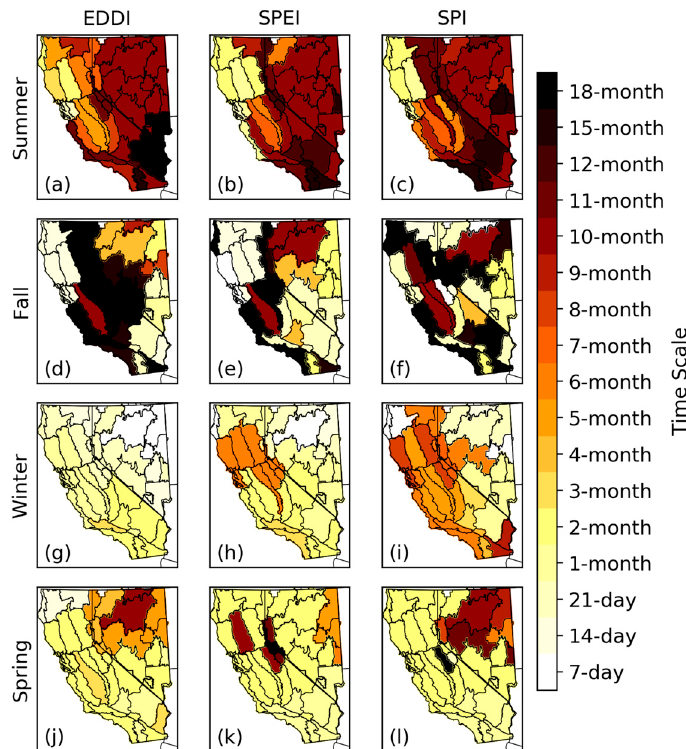
Figure 7. Time scale of each drought index associated with the 90-day lag correlations shown in Figure 5. Drought indices include ( a , d , g , j ) EDDI, ( b , e , h , k ) SPEI, and ( c , f , i , l ) SPI, and seasons include ( a , b , c ) summer, ( d,e,f ) fall, ( g , h , i ) winter, and ( j , k , l ) spring.